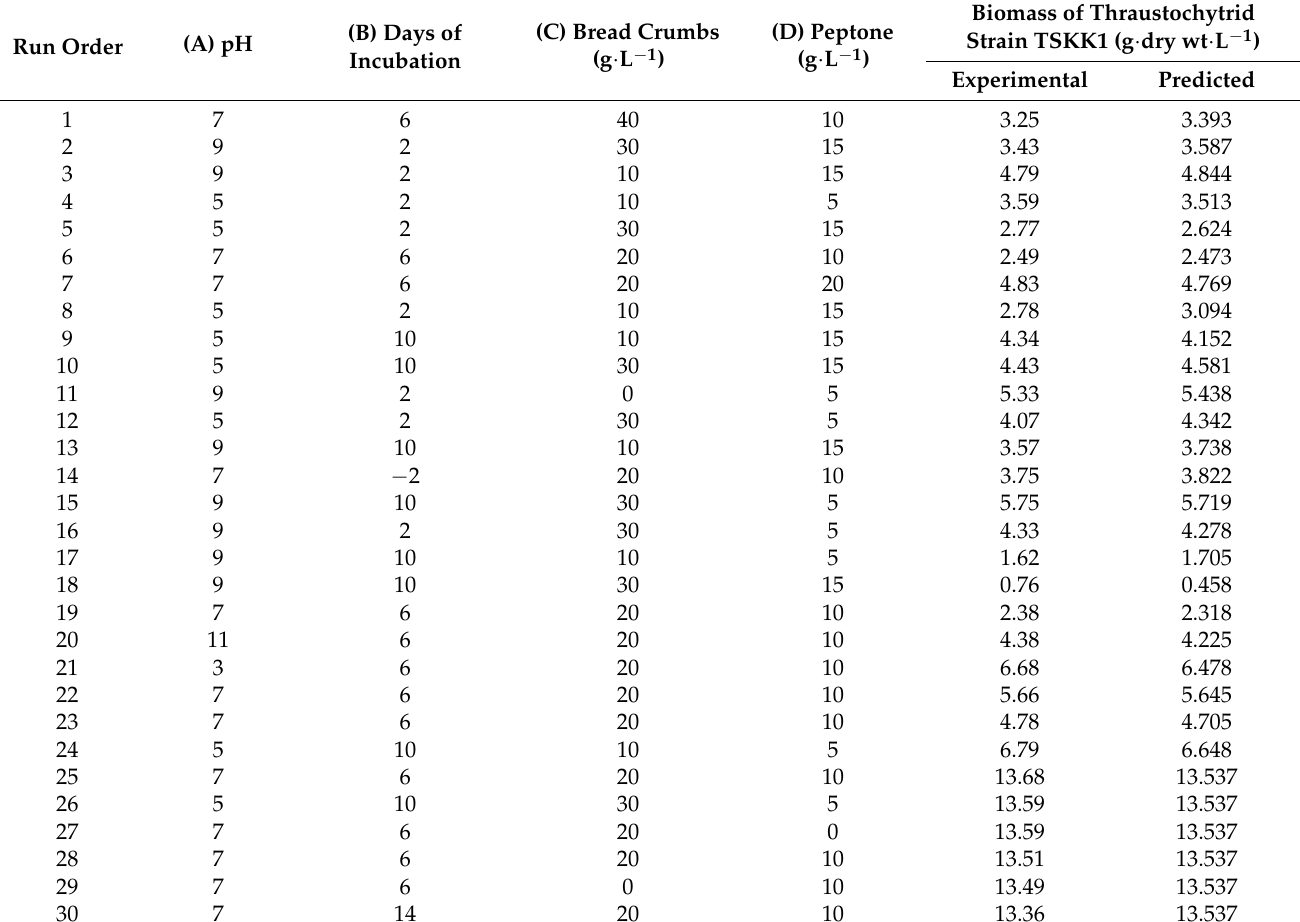
Table 3. Central composite design for the optimization of factors for biomass production by Thraustochytrium kinnei.